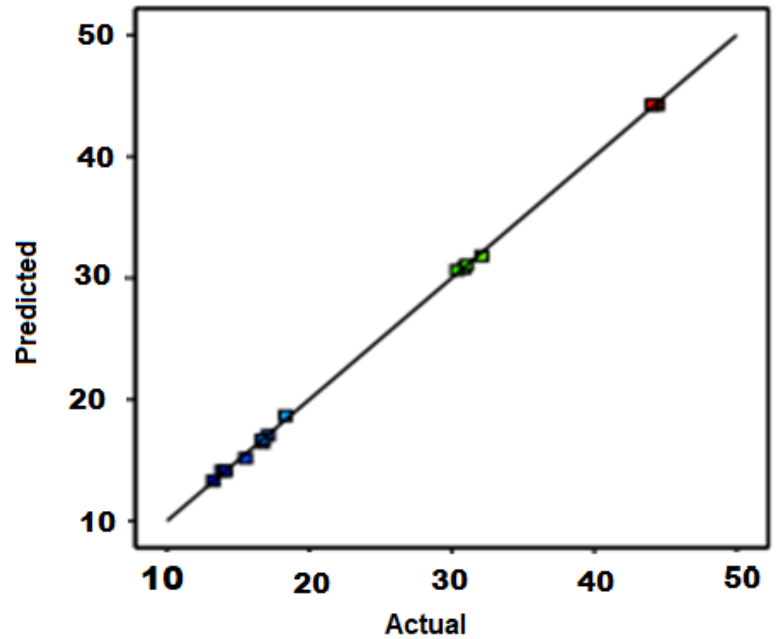
Figure 4. Actual and predicted carbon yield derived from the RSM Model.